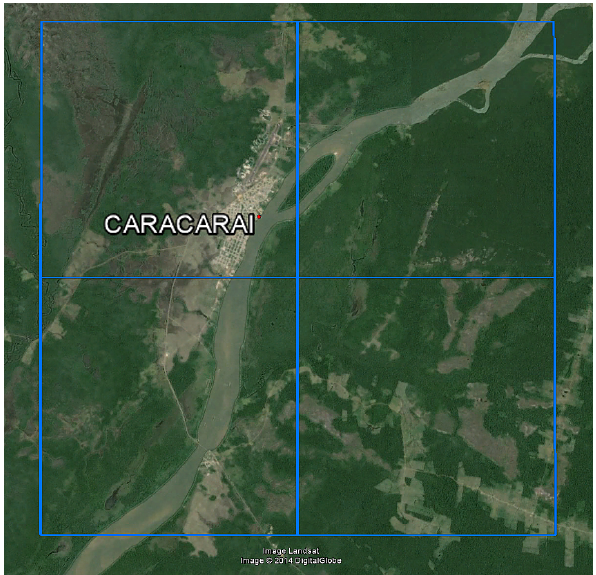
Figure 2. Example of a measurement site: Caracarai station (Rio Branco catchment, Brazil). The blue rectangles outline the mea- surement pixels and the background image is from 2014 (Google; Landsat,